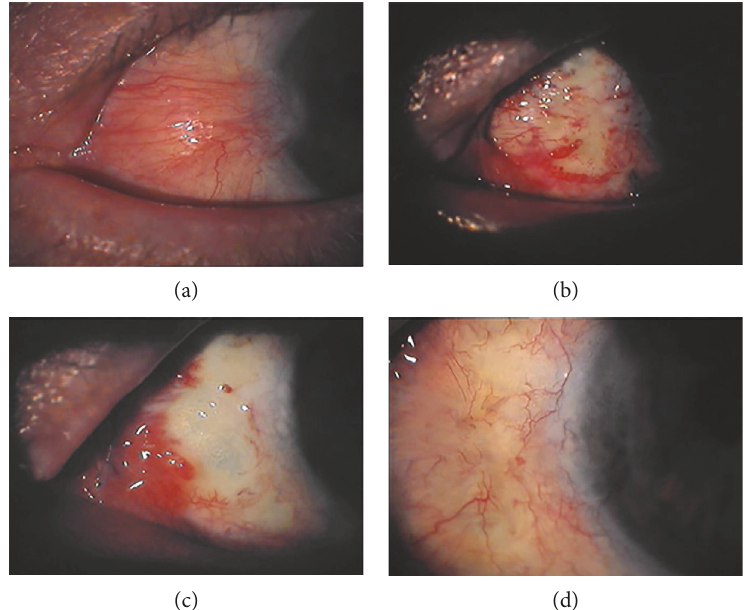
Figure 5: Results of application of subconjunctival bevacizumab injections prior and after pterygium surgery with bare sclera technique: (a) preoperative status, (b) 1 day after surgery (1 week after fi rst bevacizumab injection), (c) 1 day after second bevacizumab injection, and (d) 6-month